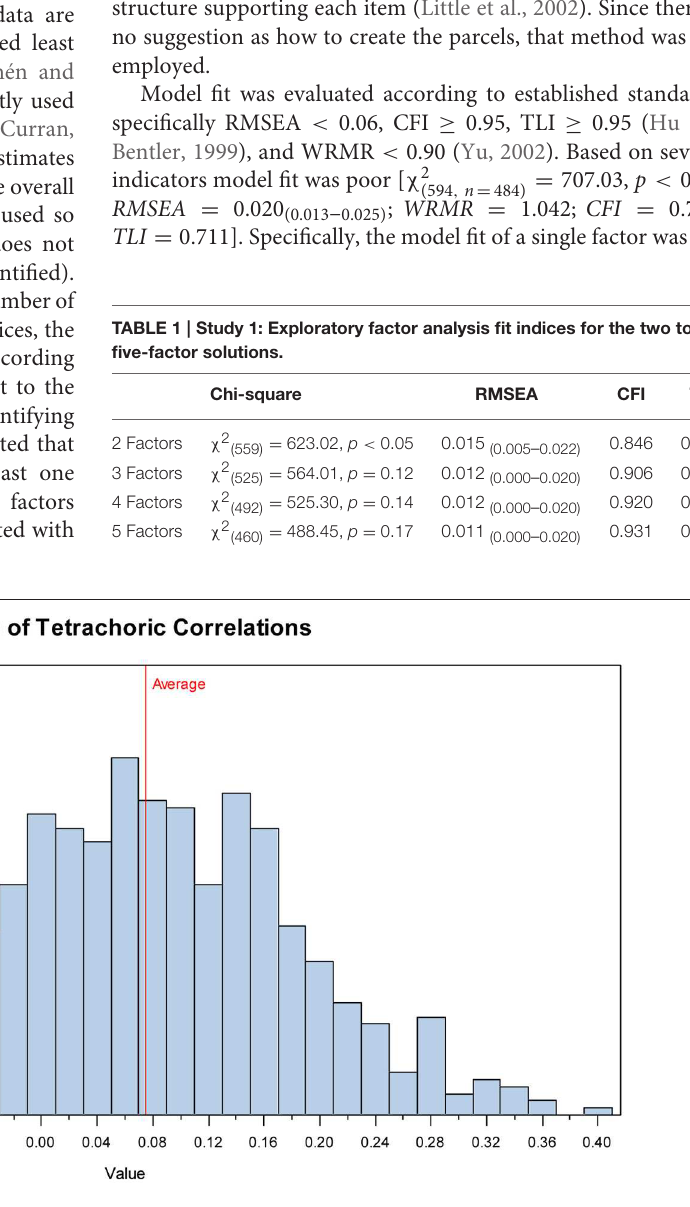
FIGURE 1 | Study 1: Distribution of the tetrachoric